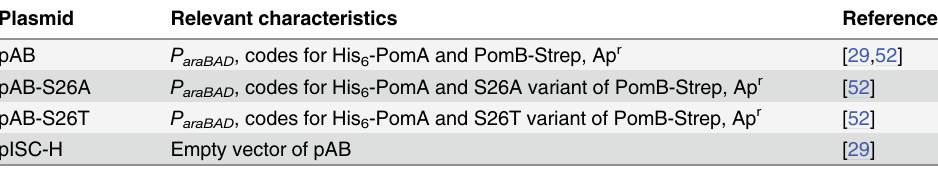
Table 1. Plasmids used in this study.